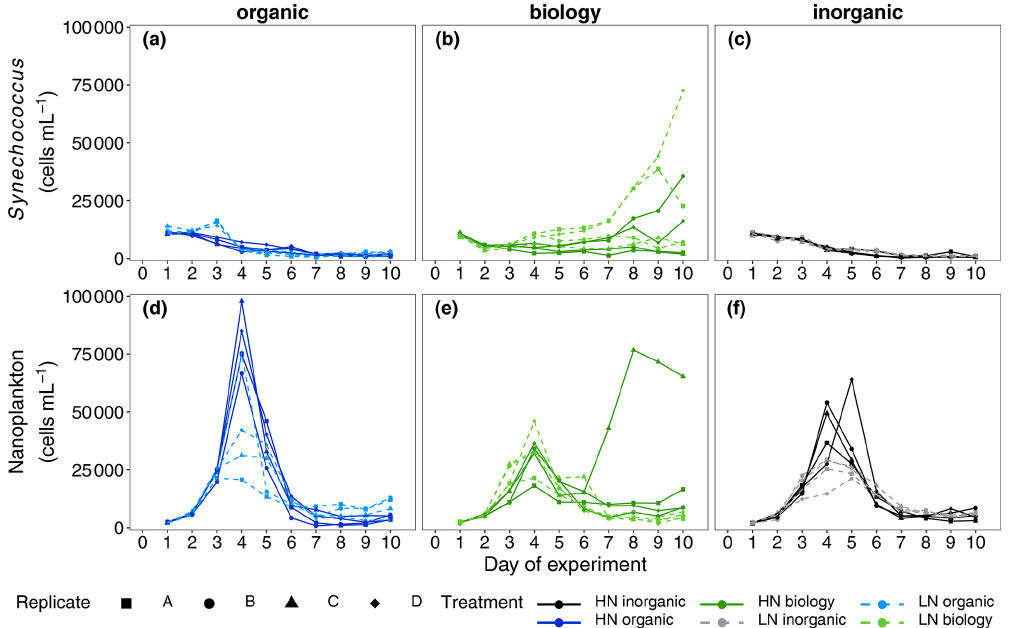
Figure 4. Abundances of two key phytoplankton groups identified in flow cytometric analyses, Synechococcus (a–c) and nanoplankton (d–f) , measured daily over the 10d long study period. A divergent response was observed between “biology” incubations in both phytoplankton groups during the nutrient-depleted post-bloom period after Day 4.